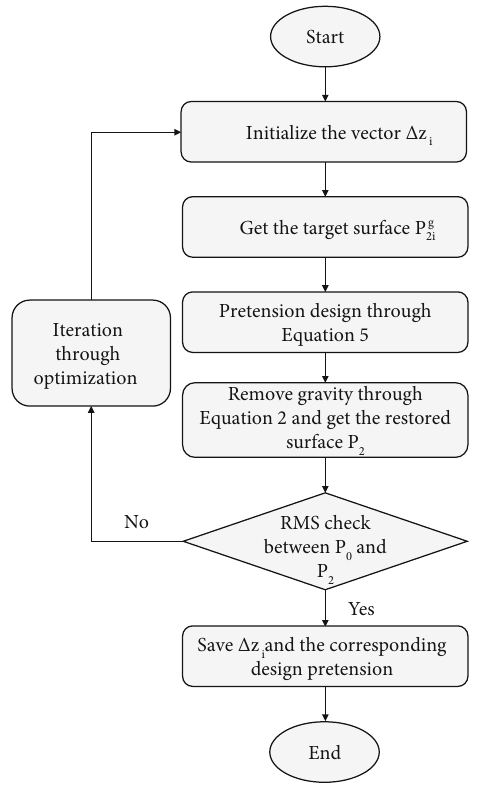
Figure 6: Algorithm of pretension optimization.